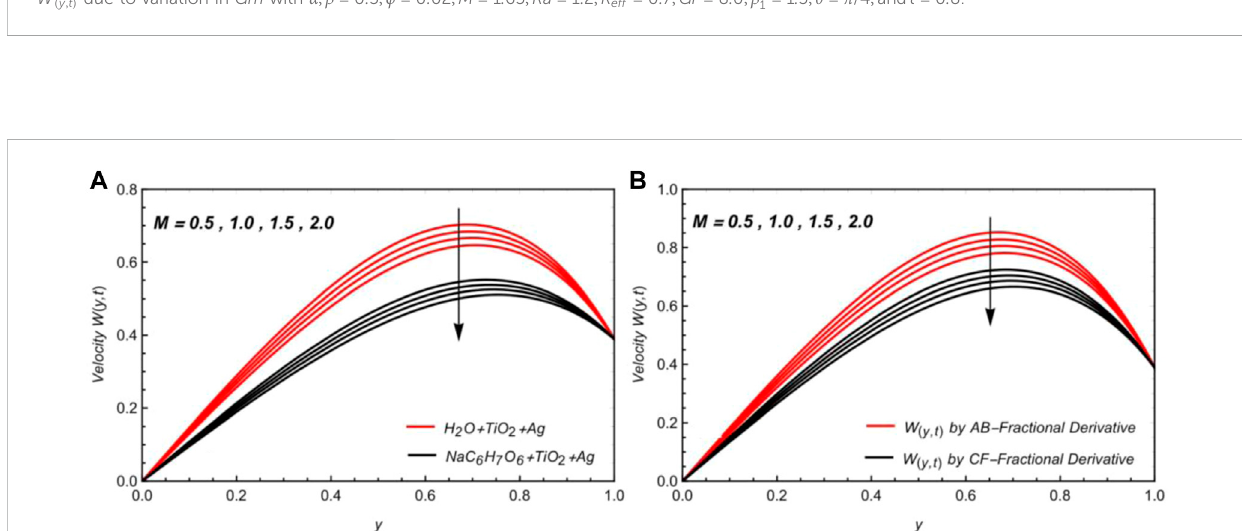
FIGURE 8 W ( y , t ) due to variation in Gm with α , β (cid:2) 0 . 5 , φ (cid:2) 0 . 02 , M (cid:2) 1 . 65 , Ra (cid:2) 1 . 2 , K eff (cid:2) 0 . 7 , Gr (cid:2) 8 . 0 , β 1 (cid:2) 1 . 5 , θ (cid:2) π /4 , and t (cid:2) 0 . 8.